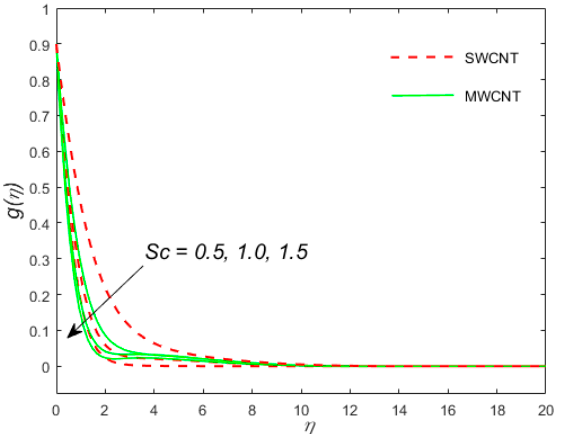
Figure 15. The variation of the concentration profile g ( η ) for the case of SWCNT and MWCNT versus the similarity variable for the distinct values of the Schmidt number Sc .